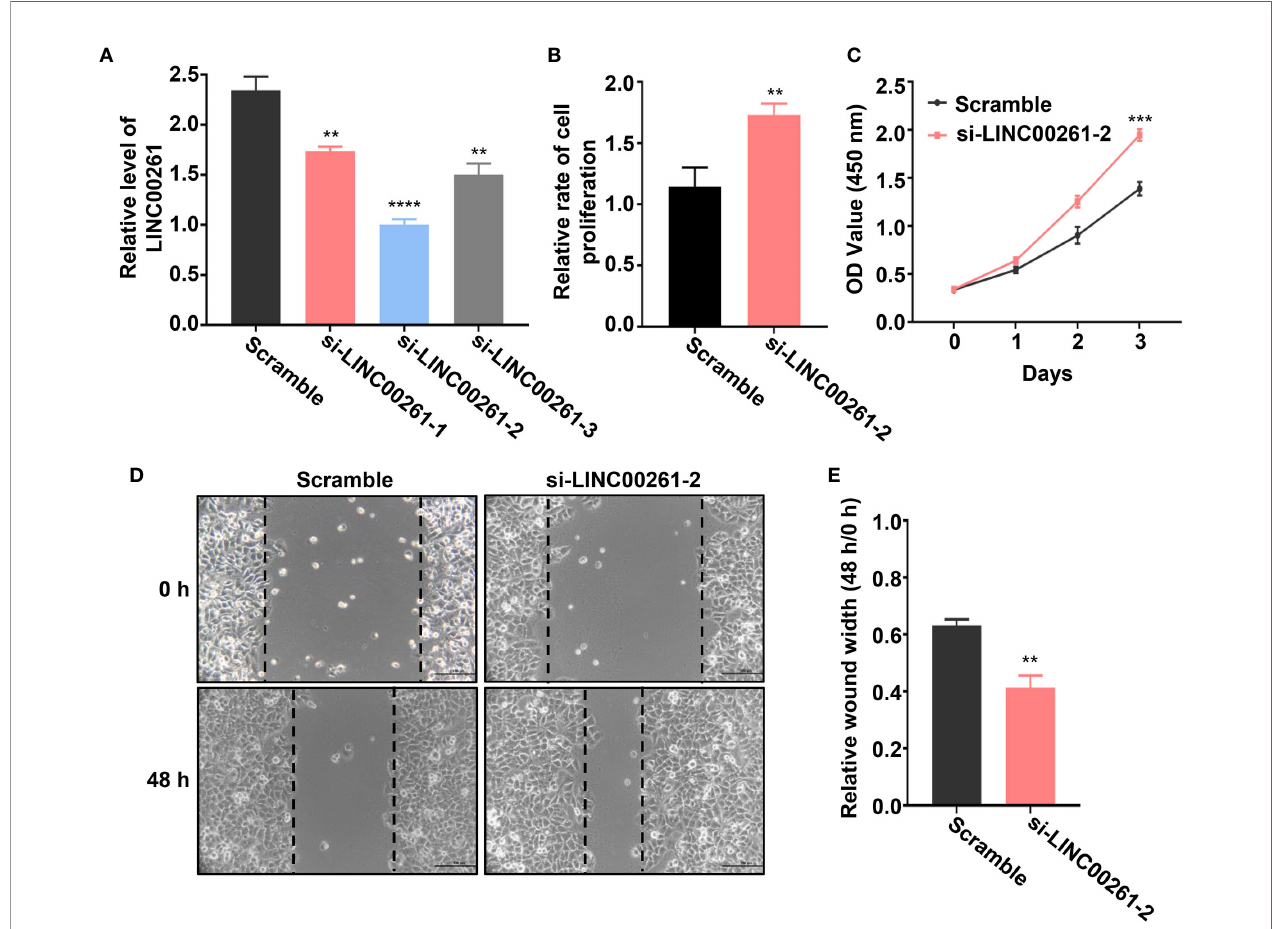
FIGURE 7 | (A) Relative LINC00261 expression level in MHCC-97H cells detected by qPCR after transfected with scramble siRNA, si-LINC00261-1, si-LINC00261- 2 and si-LINC00261-3. ** means P < 0.01, **** means P < 0.0001. (B) Relative cell proliferation of MHCC-97H cells transfected with scramble siRNA and siLINC00261-2. ** means P < 0.01. (C) Cell viability of MHCC-97H transfected with scramble siRNA and si-LINC00261-2. *** means P < 0.001. (D, E) Wound healing results of MHCC-97H transfected with scramble siRNA and si-LINC00261-2. ** means P <